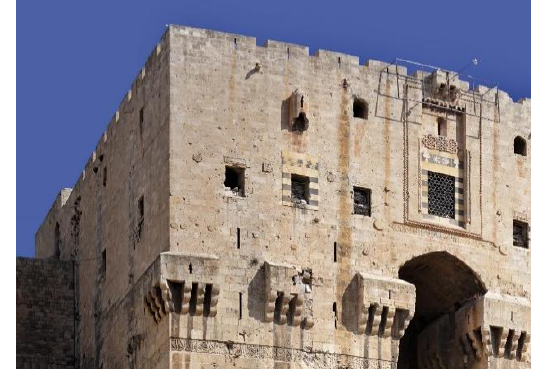
Figure 6: Entrance tower of the Citadel.